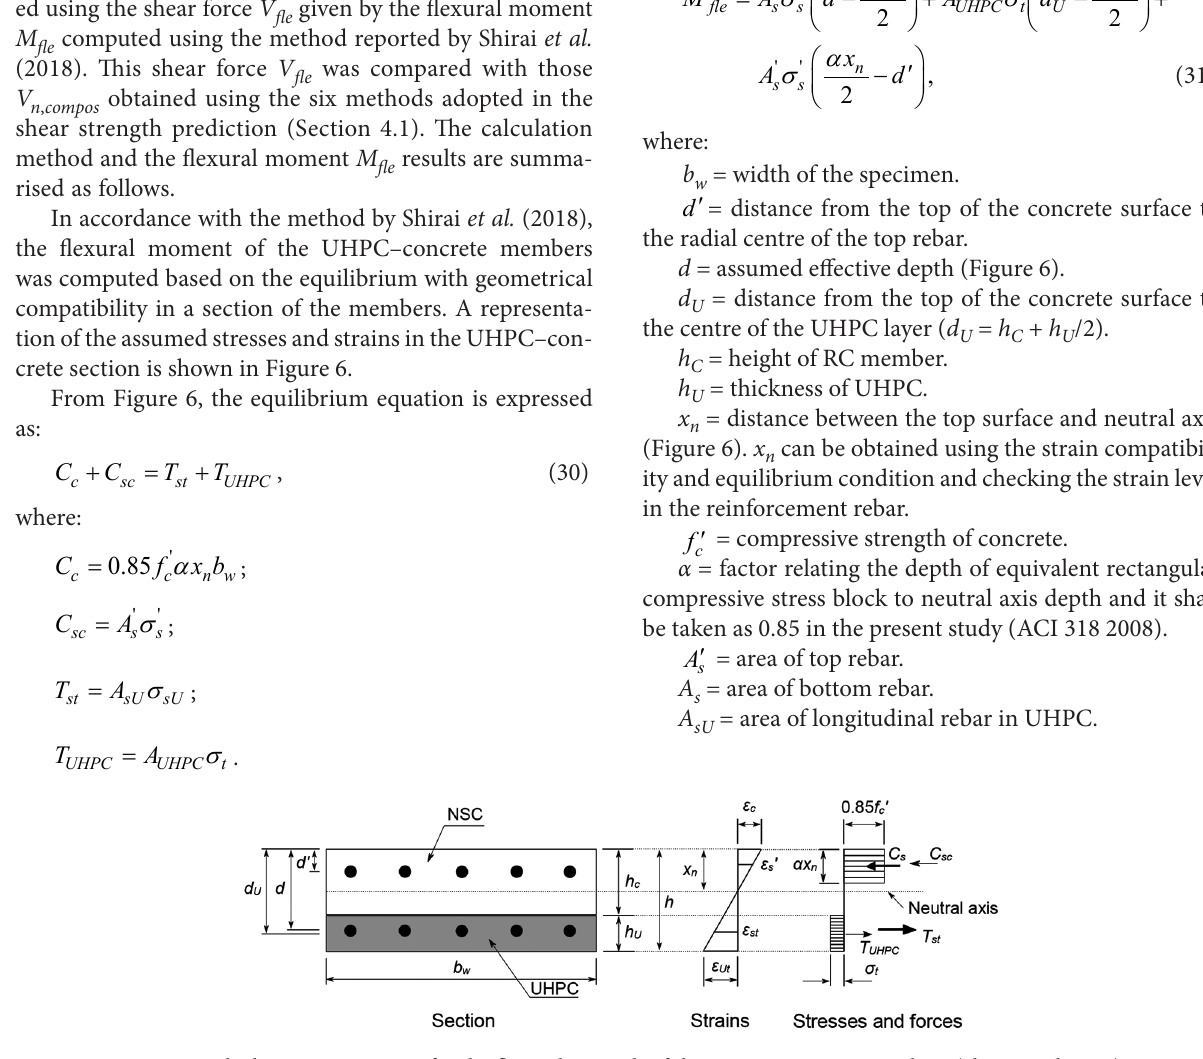
Figure 6. Calculation assumptions for the flexural strength of the UHPC–concrete members (Shirai et al.